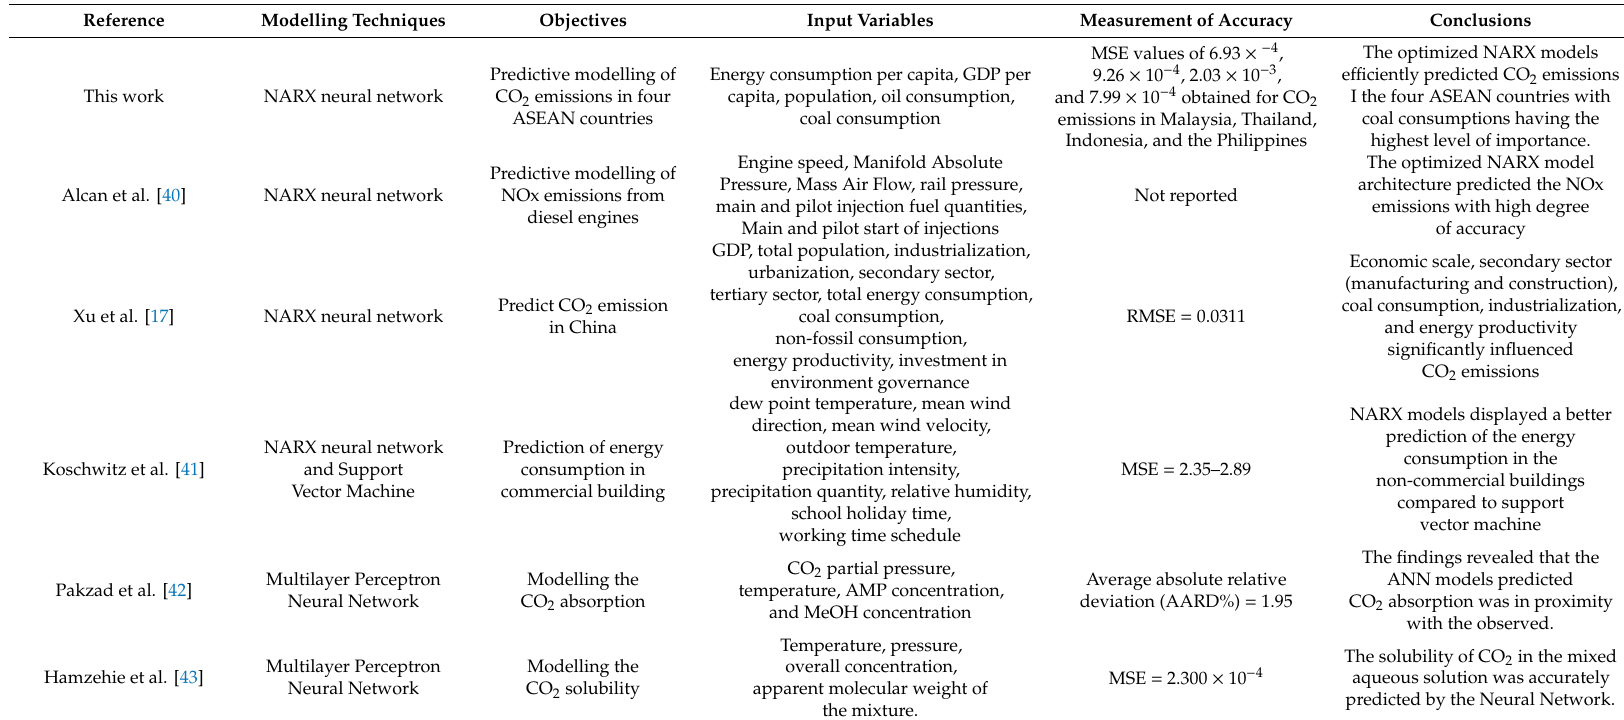
Table 7. Comparison of the present work with